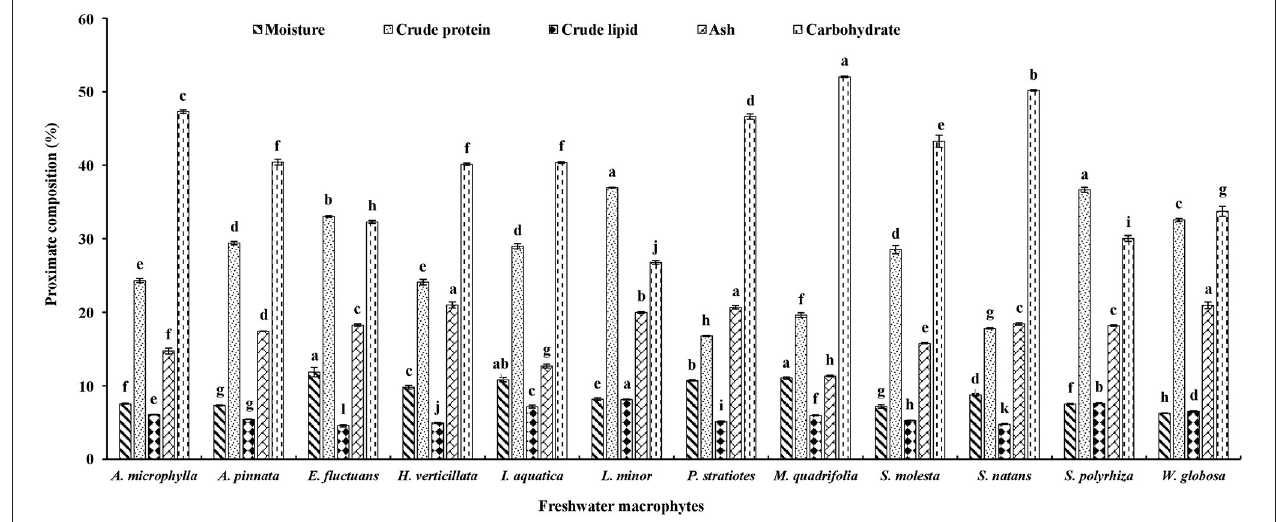
FIGURE 1 | Proximate composition of twelve freshwater macrophytes cultured with organic manures. Bars with different superscripts are significantly different ( n =